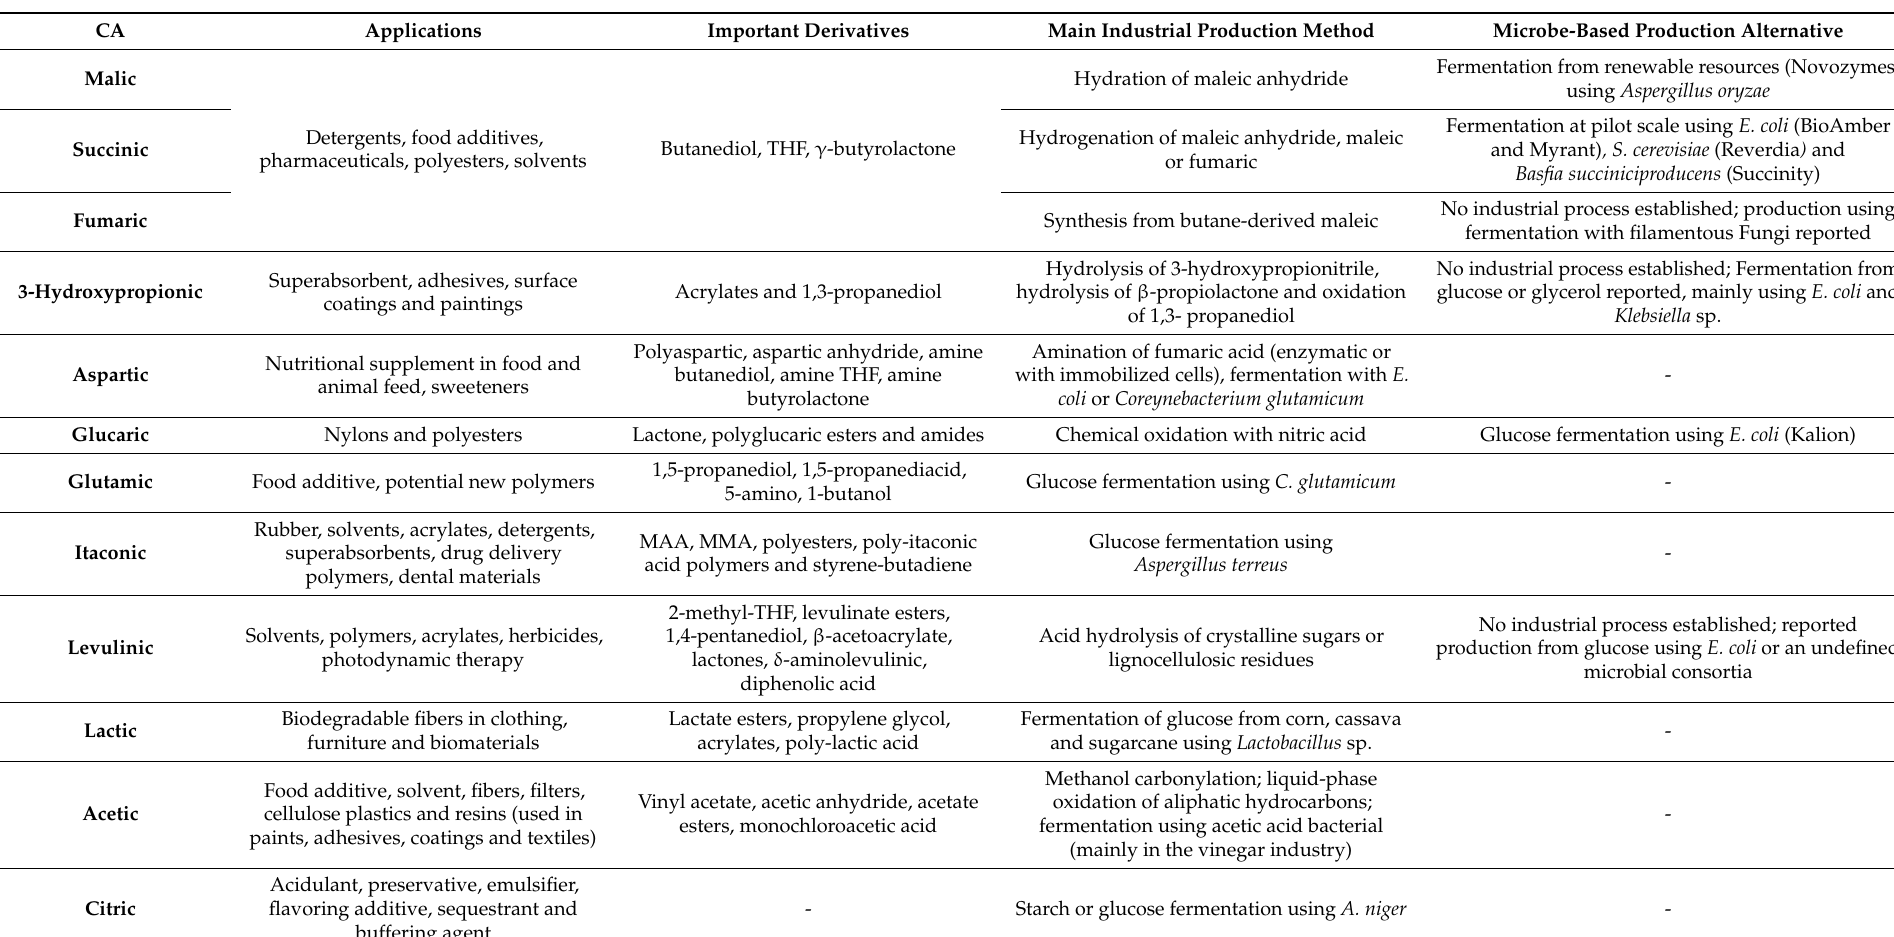
Table 1. CAs identified as more interesting green building blocks, according to reports identified by the US DOE [8,10] or by the European research project BREW [9]. Showing the application, the main industrial production method, the already described possibilities of production via microbial fermentation (for those cases in which fermentation is not already the main production method) and the derivatives with the potential to displace oil-derived precursors. Relevant references are provided in the text. MAA-methacrylic acid; MMA-methylmethacrylic acid;